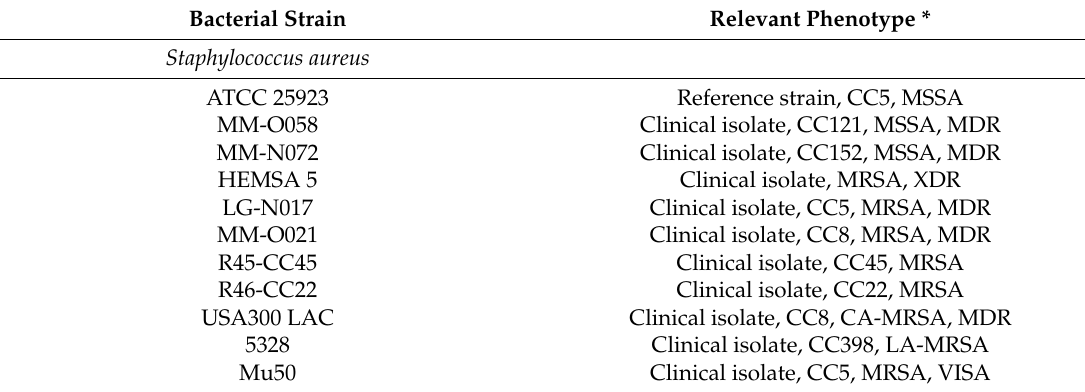
Table 1. Characteristics of the ESKAPE Gram-positive strains used in this study.